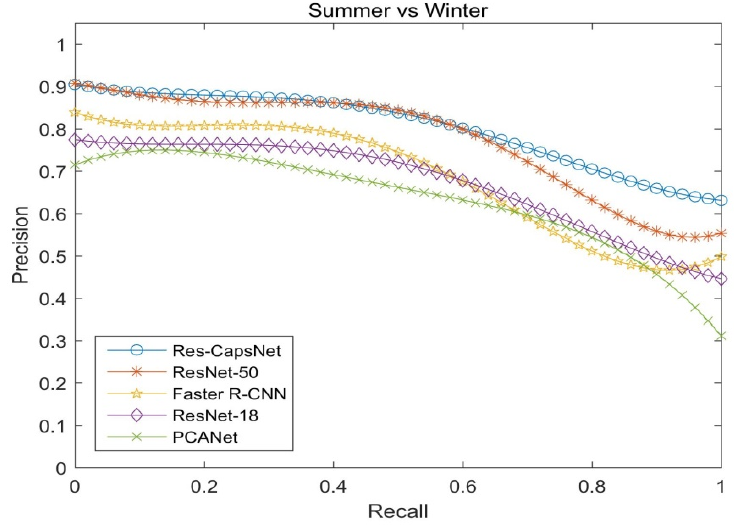
Figure 14. Precision–recall curves of four seasons comparison (summer vs. winter).